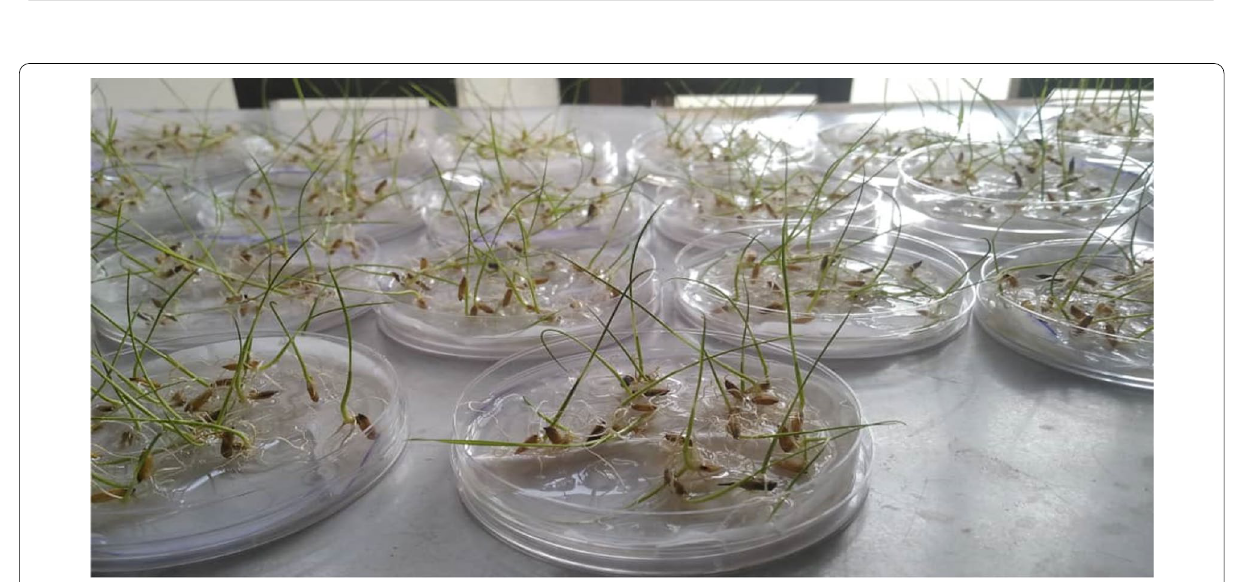
Fig. 13 In vitro growth of rice after inoculation with the three PSBs at 6DAS. DAS